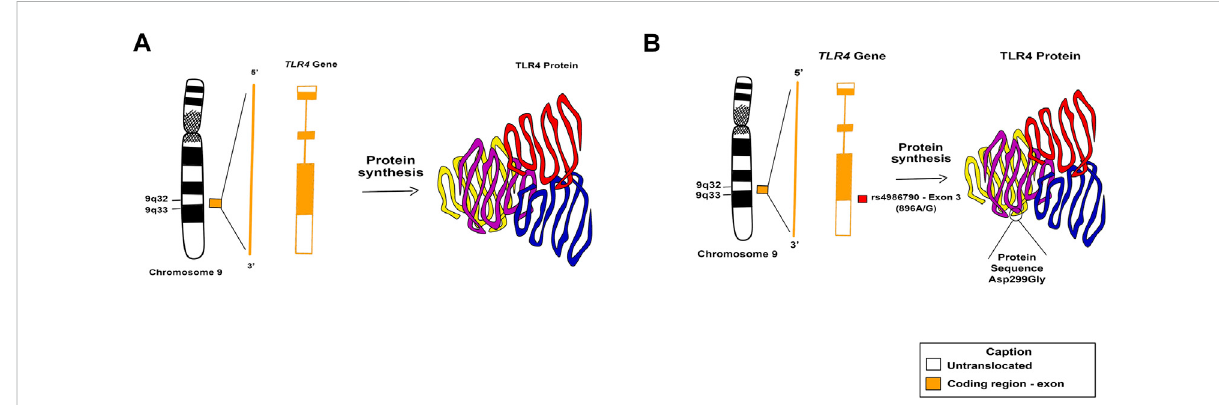
FIGURE 1 Location of the SNP rs4986790 on the TLR4 gene. (A) Normal structure of the TLR4 gene and protein. (B) SNP rs4986790 in the altered gene TLR4 and protein